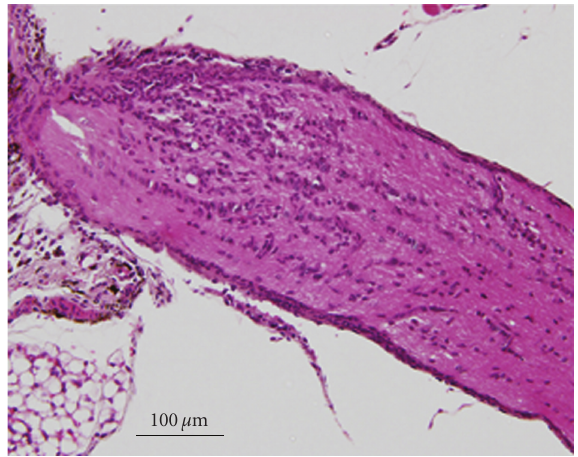
Figure 1: Histopathological findings of the optic nerve from a mouse adjuvant immunized with MOG peptide. Marked cell infiltration is observed in the optic